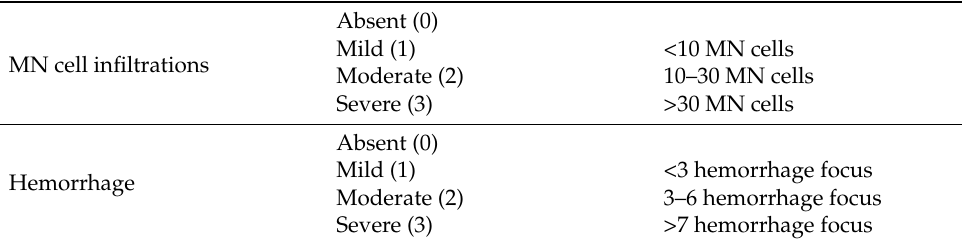
Table 1. Histopathological scores of cardiac